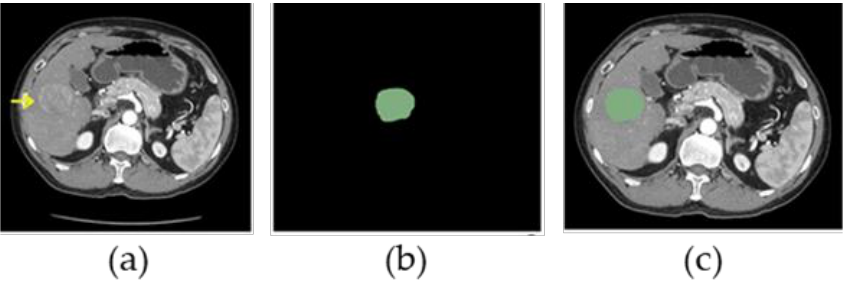
Figure 2. 54-year-old man with hepatocellular carcinoma (HCC). ( a ) Original arterial phase CT scan slice shows the HCC lesion (yellow arrow). ( b ) ROI (green area) manually drawn in accordance with the HCC lesion. ( c ) Arterial phase CT scan slice shows an overlapped image of ROI (green area) and raw CT image.